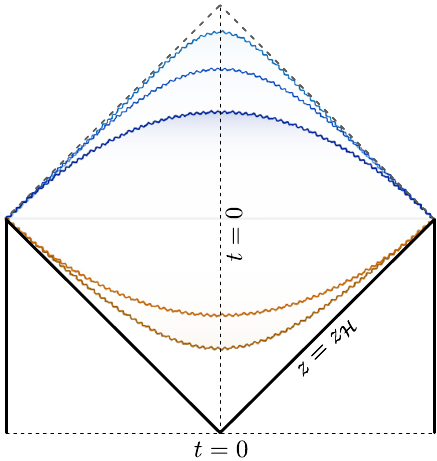
Figure 7 . Penrose diagrams for the grand canonical ensemble. At low temperatures or for small de- formations, the singularity bulges up and approaches the Cauchy horizon of the Reissner-Nordstr(cid:127)om solution, shown with grey dashed lines. At su(cid:14)ciently high temperatures the singularity instead bulges